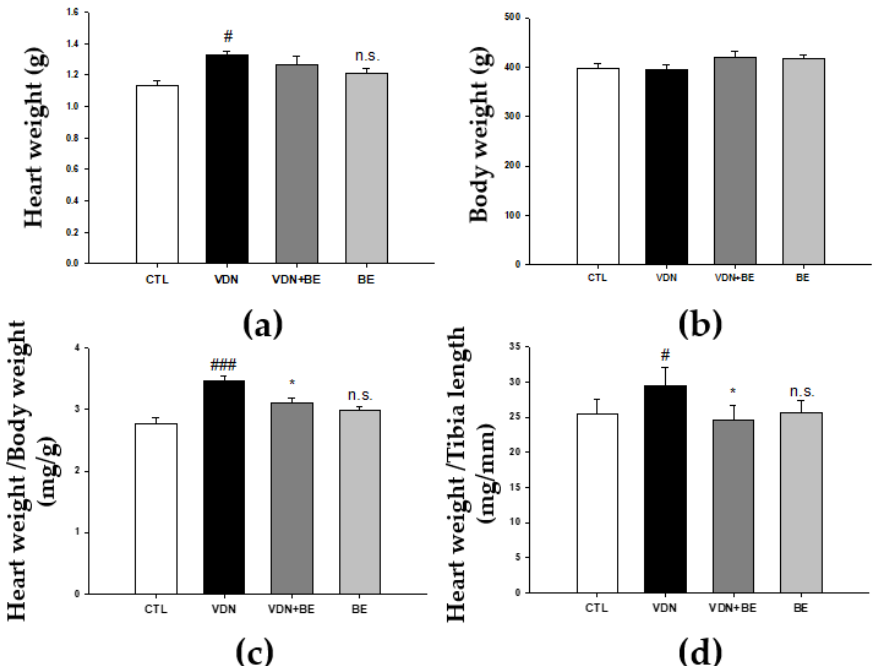
Figure 6. The effects of baicalein on heart and body weight in SD rats. ( a ) Heart weight (g), ( b ) body weight (g), ( c ) heart and body weight ratio (mg/g), and ( d ) heart weight and tibia length ratio (mg/mm). Each point represents the mean ± SEM, n = 10. # p < 0.05; ### p < 0.001 compared with the control group; * p < 0.05 compared with VDN group; n.s. mean not significant vs. control group.